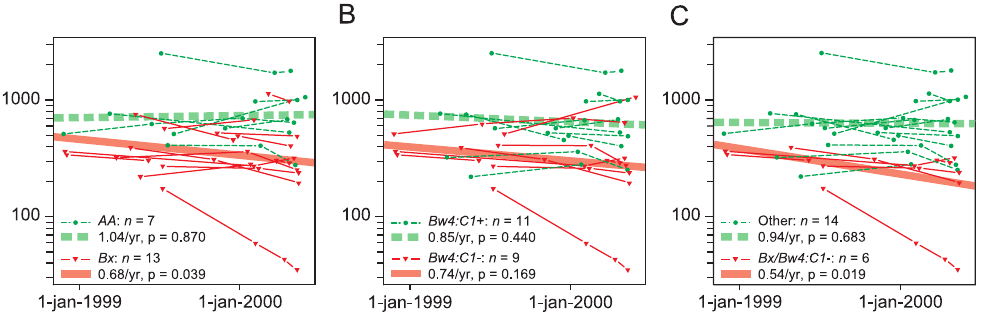
Figure 2. Effect of KIR and HLA genotypes on the rate of CD4 + T cell decline among HIV-1 infected subjects. Thin lines represent individual CD4 + T cell count profiles (n=20). Thick lines represent the fitted models calculated by mixed-effects linear regression analysis. (A) Effects of AA and Bx genotypes. (B) Effect of Bw4:C1 genotype. (C) Effect of Bx genotype in the absence of Bw4:C1 . Bw4:C1 denotes the simultaneous occurrence of Bw4 and C1 . The estimated fold decrease in CD4 + T cell count per year and p values are shown.